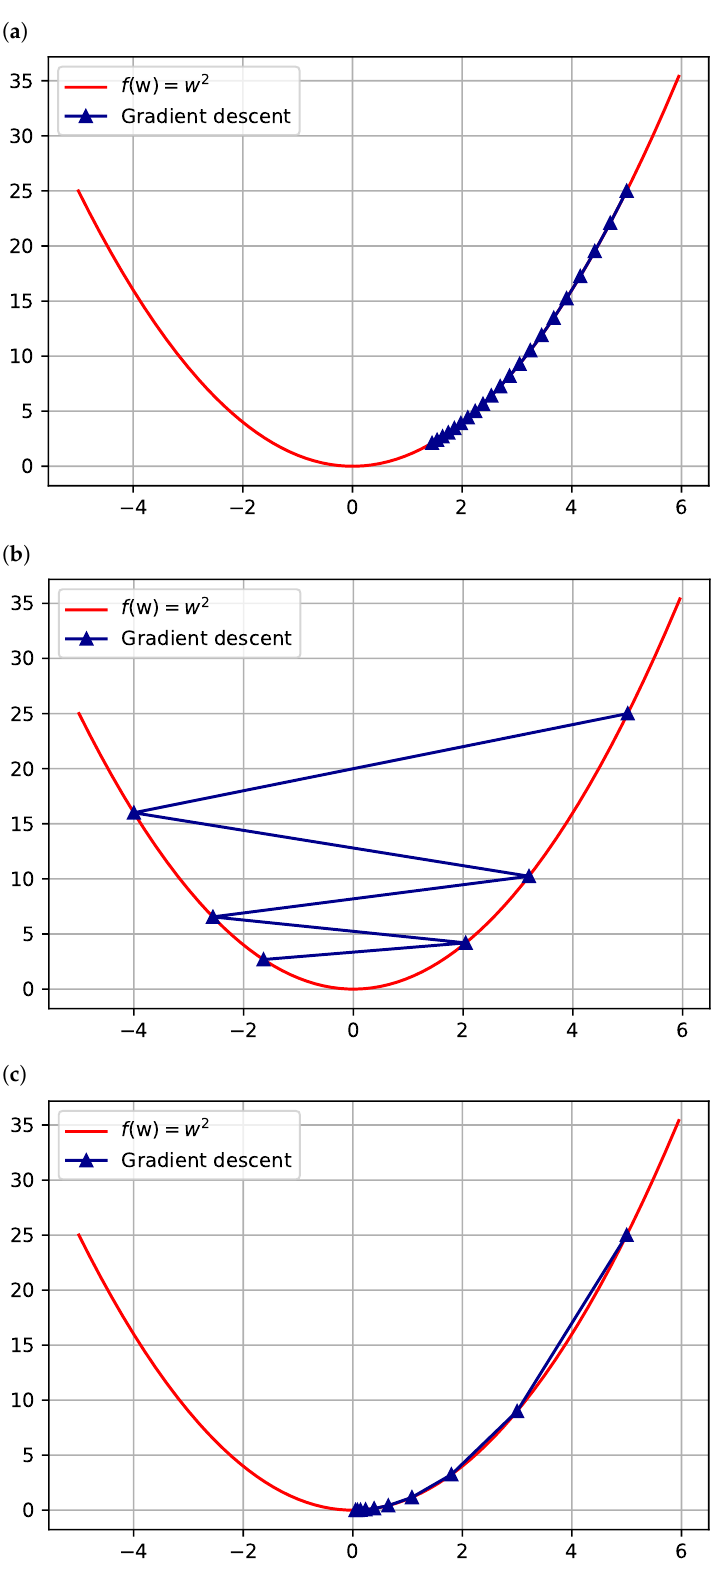
Figure A2. Three different selections of the learning rate and their impact on the gradient descent when applying to minimise a function. ( a ) Too small η ; ( b ) Too large η ; ( c ) Optimal η